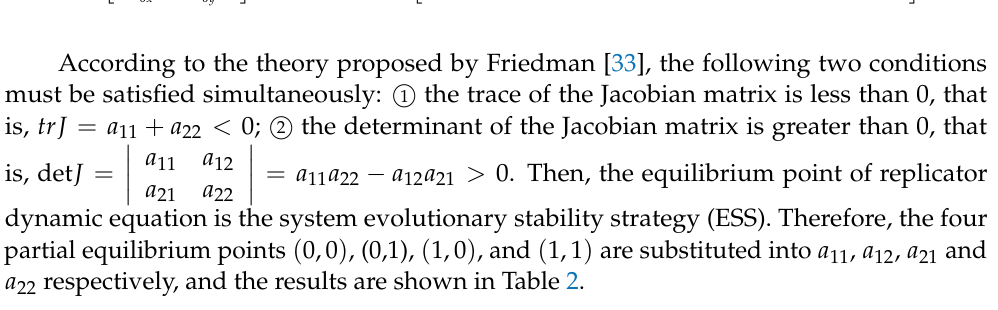
Table 2. Specific values at the partial equilibrium point. Partial Equilibrium